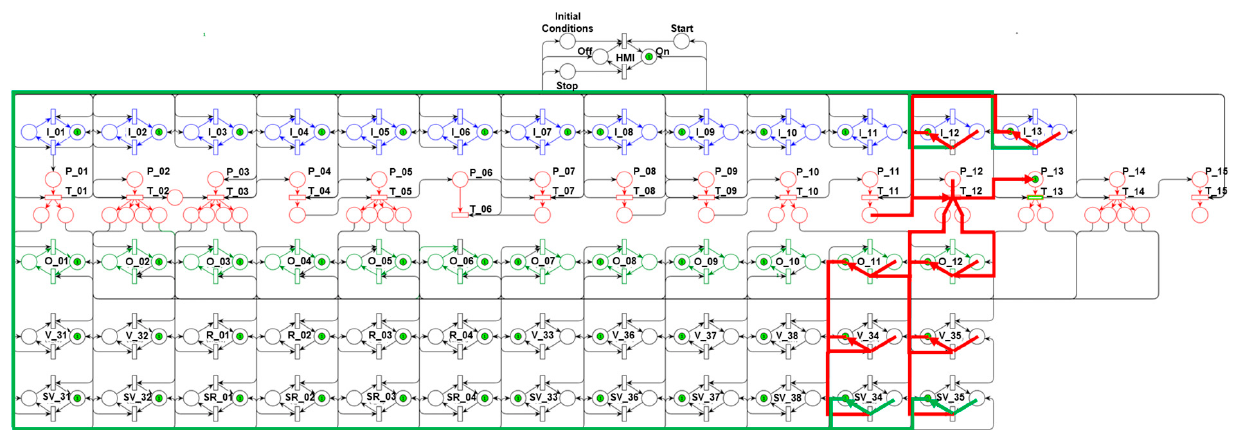
Figure 34. Algorithm’s 14th step—Close valves.